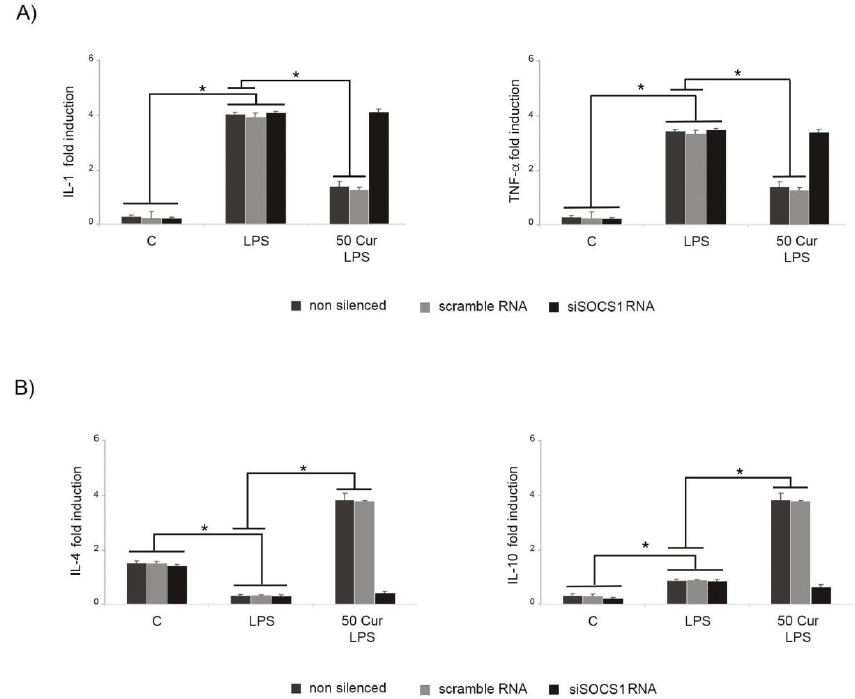
Figure 5. Effect of SOCS-1 downregulation on cytokine production determined by RT-PCR. Microglial cells were transfected with either control siRNA (scramble RNA) or SOCS-1 specific siRNA (siSOCS1 RNA). Untransfected cells were used as control (C). ( A ) Pro-inflammatory cytokine production in LPS-stimulated BV-2 cells. ( B ) Anti-inflammatory cytokine production in LPS-activated BV-2 microglial cells. Cells were incubated for 6 h with LPS alone, or after 1 h of pretreatment with 50 µ M curcumin (Cur). Experiments were performed in triplicate, and data are expressed as the mean ± SD of five independent experiments. * p <